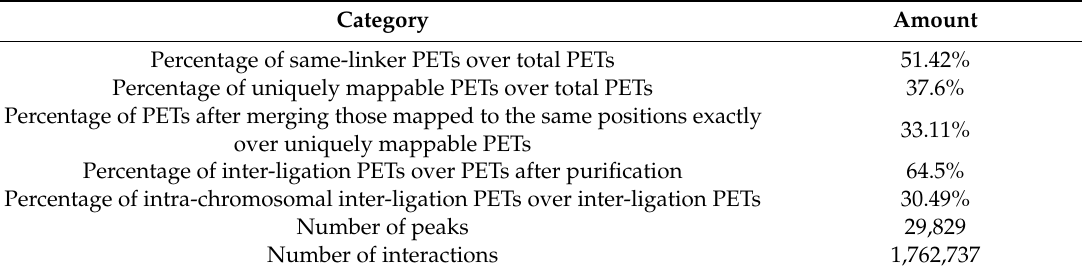
Table 7. Statistics of ChIA-PET library from human GM12878